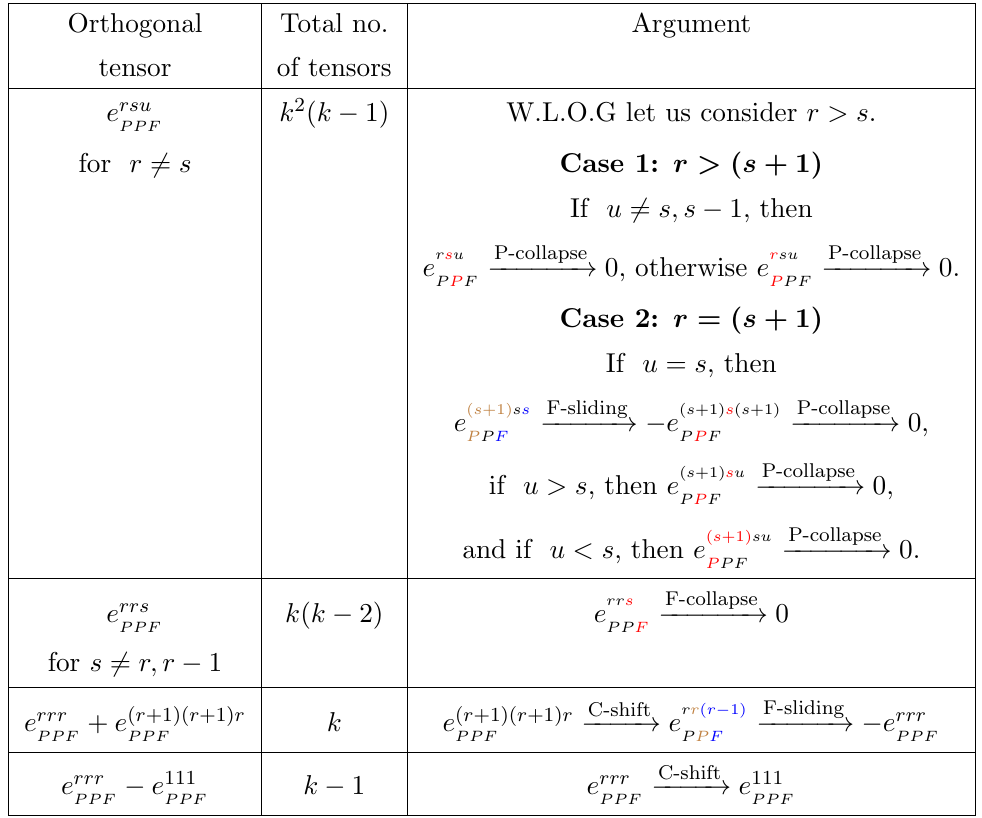
Table 3 . Arguments for the tensors in the PPF sector orthogonal to the array of 3 point contour